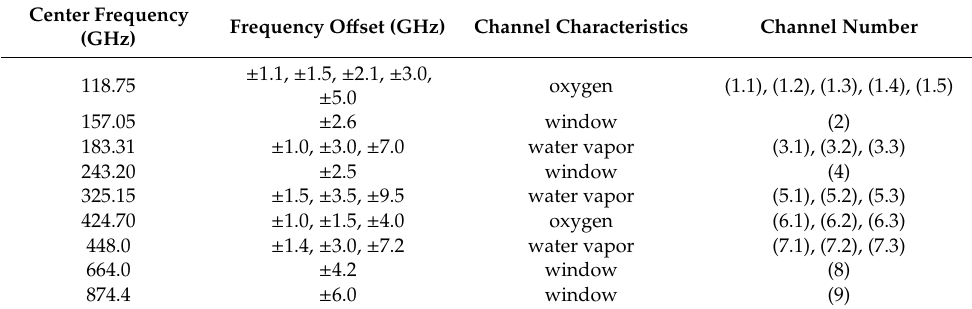
Table 1. Information of representative